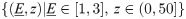
Complex dynamics of model (4).Top row: parametric portrait of the qualitative dynamics of model (4) in the domain {(E_,z)|E_∈[1,3],z∈(0,50]} at r = 10, w = 1.5, p = 0.1, E¯=4, ε = 0.05. White areas show the parameter regions in which only one fixed point, (5), was detected. This fixed point is an attractor. The blue region bordering the white one corresponds to the case in which fixed point (5) becomes a repeller and the second equilibrium, (6), emerges. Equilibrium (6) is locally asymptotically stable. Green areas are the domains in which an attracting periodic orbit was detected. The red area corresponds to regions where complex chaotic-like dynamics were observed. The black line indicates a boundary beyond which co-existence of multiple attractors was observed consistently in all experiments. Inlet linked to the gray area shows estimates of transition boundaries (dashed blue (z¯2 in (9)), green, and black (z¯3 in (9)) lines) relative to the ones observed in experiments. The yellow region shows the domain in which all trajectories converged to (7). A,B,C,D: typical dynamics observed in the corresponding parametric regions.